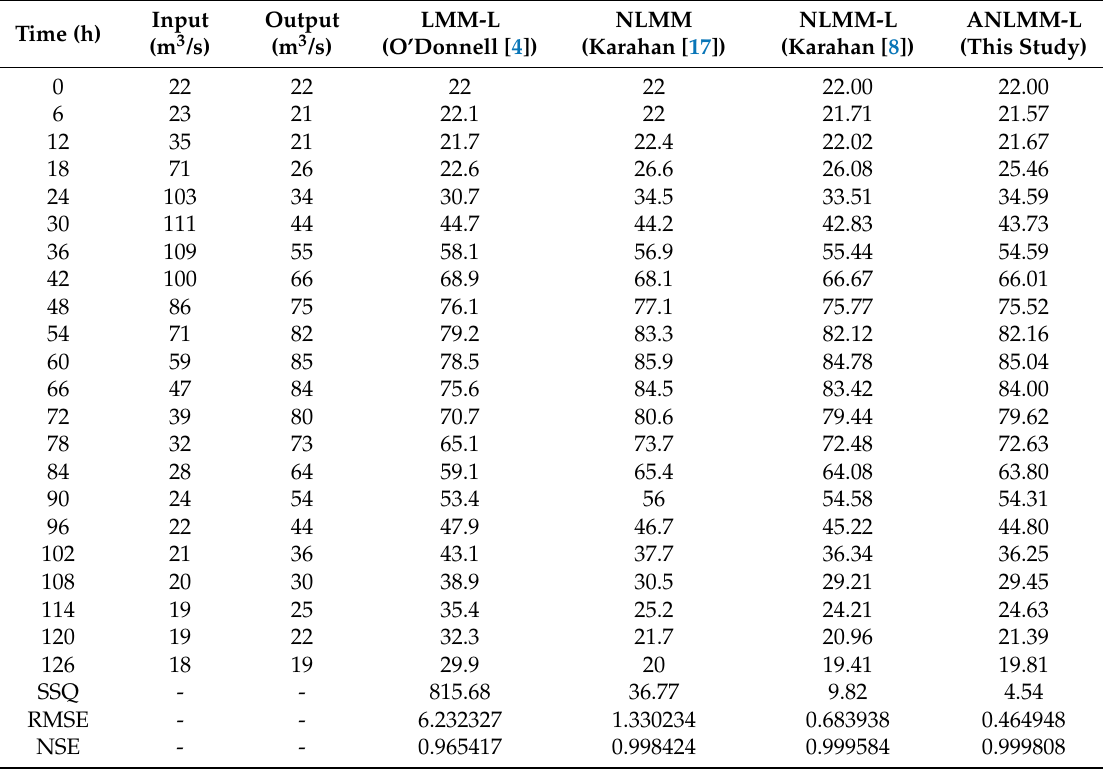
Table 4. Comparison of the outflow hydrographs calculated for the Wilson flood